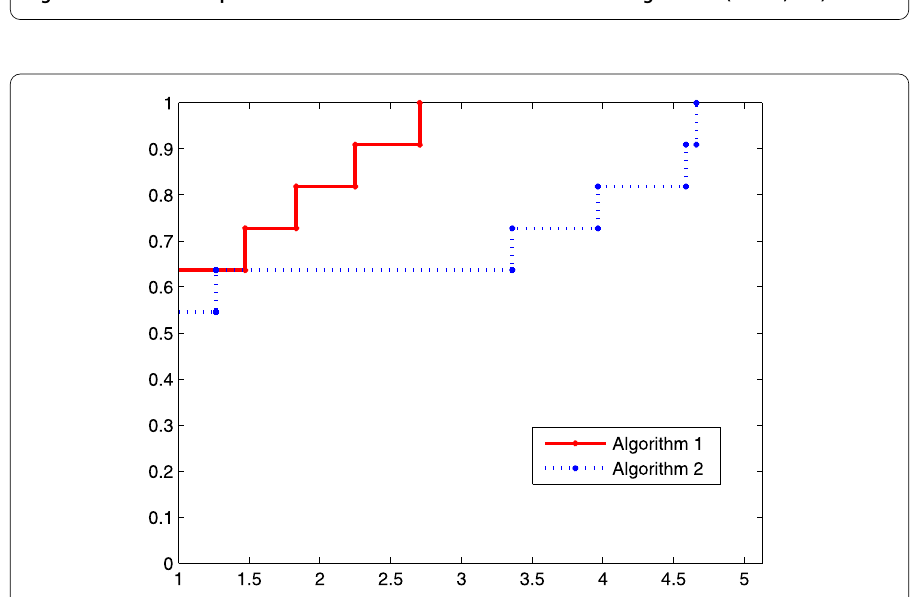
Figure 4 Performance profiles of the CPU time of two algorithms ( n =